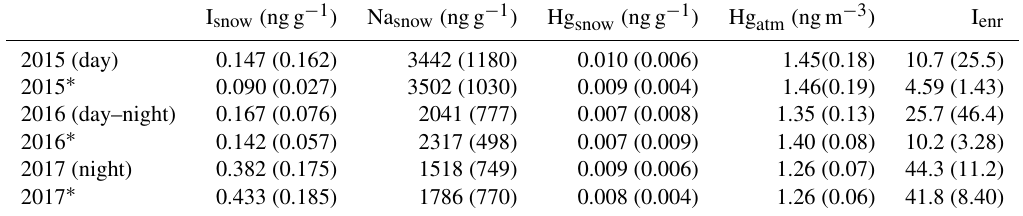
Table 1. Concentration of iodine and its enrichment in surface snow (I snow , I enr ), surface snow mercury (Hg snow ), atmospheric mercury (Hg atm ), and surface snow sodium (Na snow ) during the different experiments. Concentrations and standard deviation (in brackets) are calcu- lated for the entire dataset; an asterisk indicates that the concentration has been calculated without considering the snowfall events.